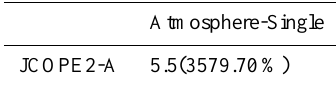
Table 4. As in Table 3, except for the parameter optimization of the JCOPE2-A case. Percent number denotes the reduced ratio of the cost function as compared to the first-guess value of